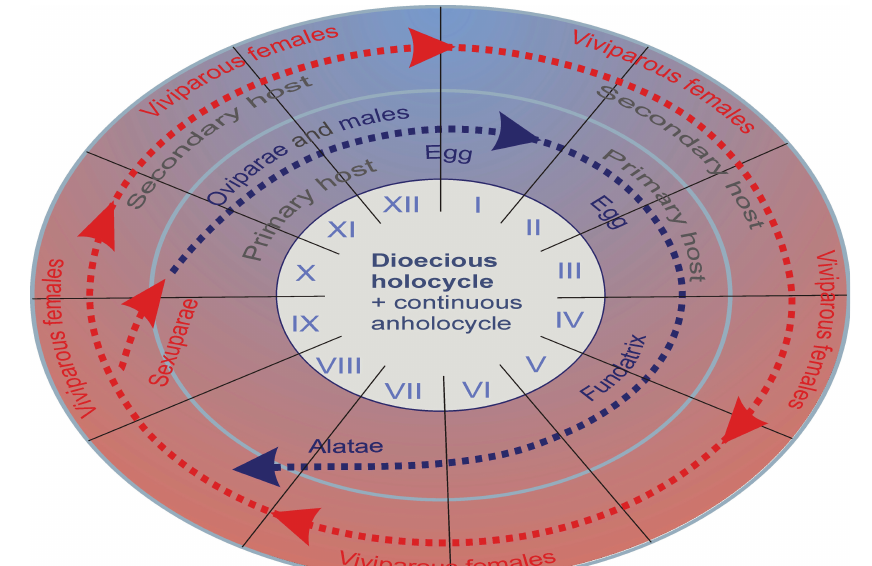
Fig. 4. Dioecious one-year holocycle accompanied by a continuous anholocycle on the secondary host, e.g., Pachypappella lactea (leaf galls on aspen, Populus tremula ; roots of spruce, Picea abies ) or Tetraneura ulmi (leaf galls on elm, Ulmus ; subterraneous parts of grasses, Poaceae). Zones as in Fig. 3. In some years the Finnish populations on the primary hosts (for P. lactea in South Finland) may be more or less absent, and their existence is dependent on the populations on the secondary hosts.